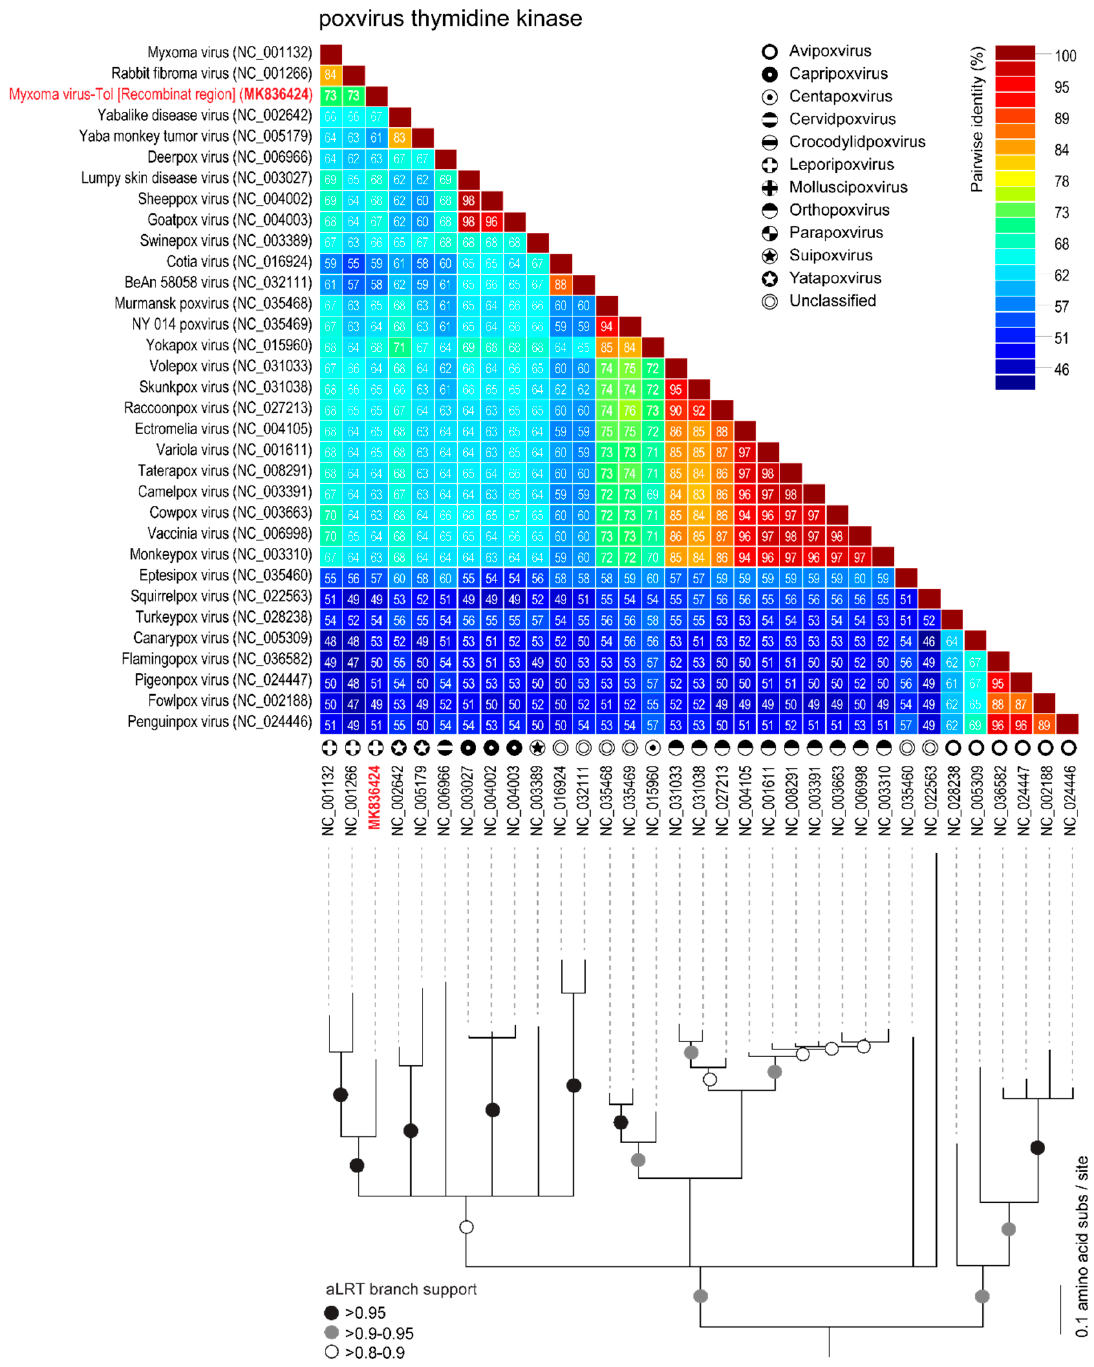
Figure 6. Pairwise amino acid identity matrix (upper image) and maximum-likelihood phylogenetic tree (model WAG+G+F), showing the relationships of the rPox-thymidine kinase (highlighted in red) found in the recombinant region of MYXV-Tol and its homologous proteins found in representative sequences (NCBI RefSeq) of poxvirus. Branches with aLRT support 0.95 are indicated with black circles, whereas branches exhibiting 0.9–0.95 and 0.8–0.9 are indicated with grey and white circles, respectively.